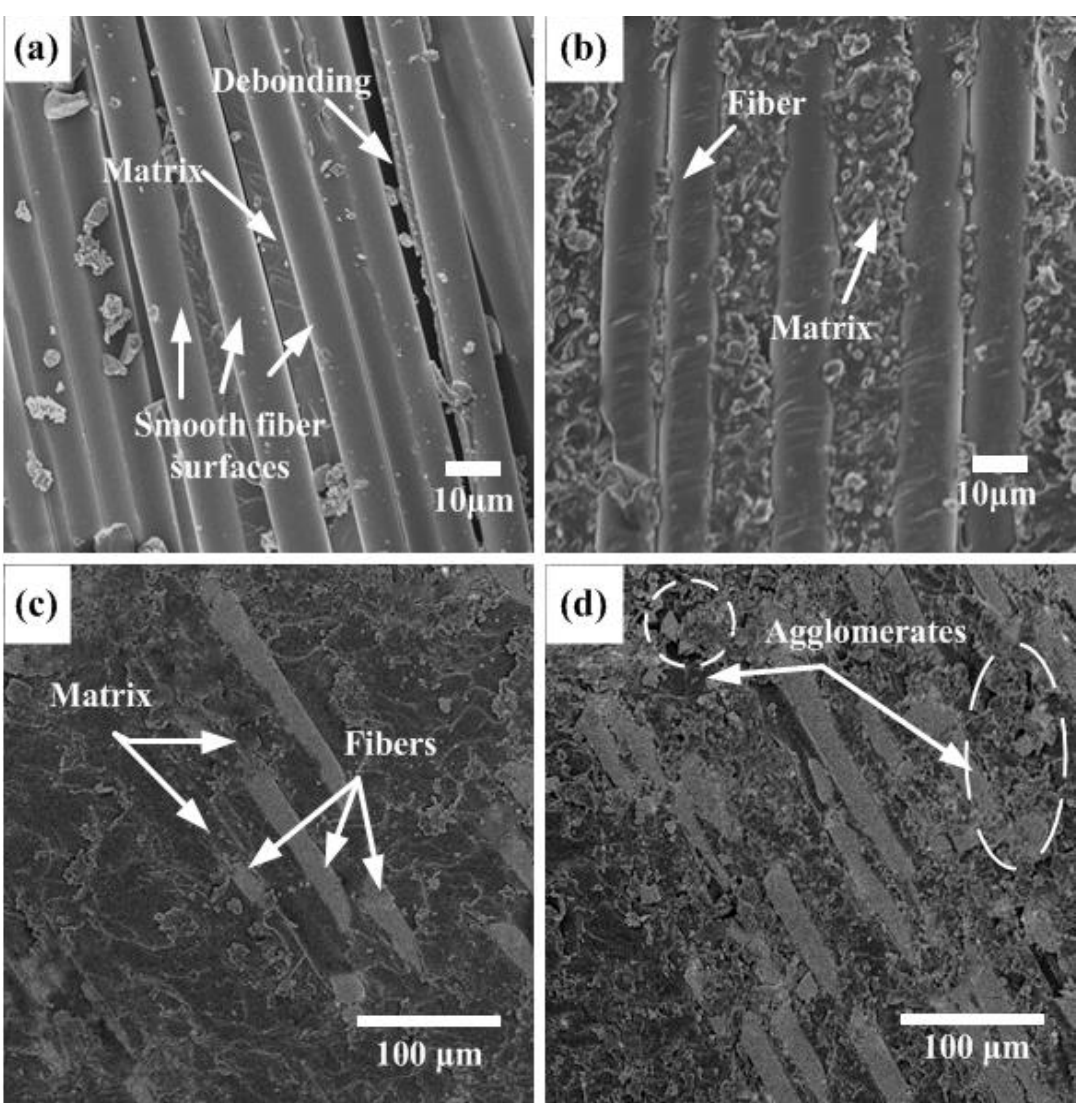
Figure 7. SEM images of the fiber/matrix surface on an HCS with: ( a ) 0 wt%: ( b ) 0.2 wt%: ( c ) 0.4 wt%: ( d ) 0.6 wt% NS content.